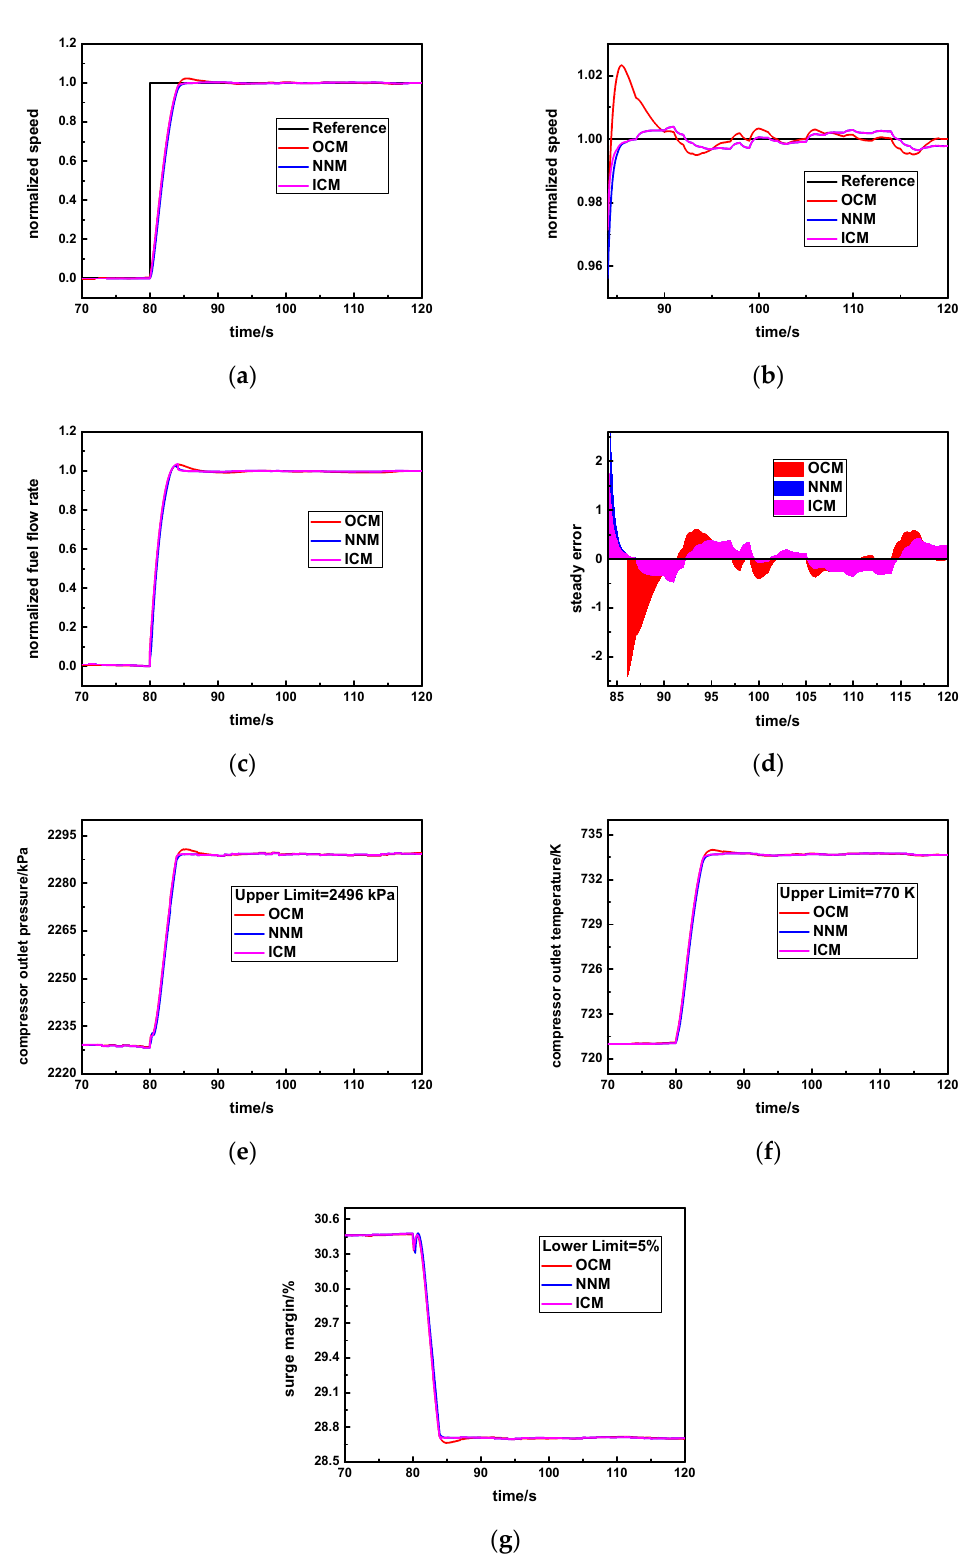
Figure 15. Related parameters distribution of third robustness test. ( a ) Speed response curve, ( b ) Locally enlarged speed curve, ( c ) Fuel flow rate curve, ( d ) Steady error, ( e ) Compressor outlet pressure, ( f ) Compressor outlet temperature, ( g ) Surge margin of compressor.